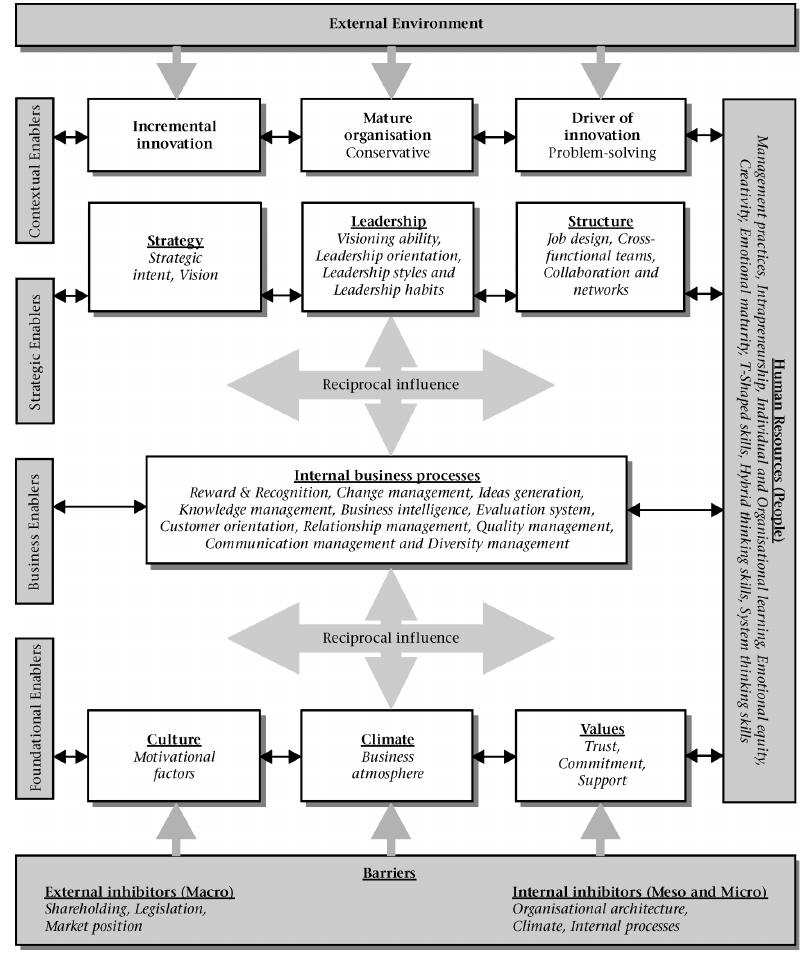
Figure 5: An integrated conceptual framework on building blocks of innovation in the